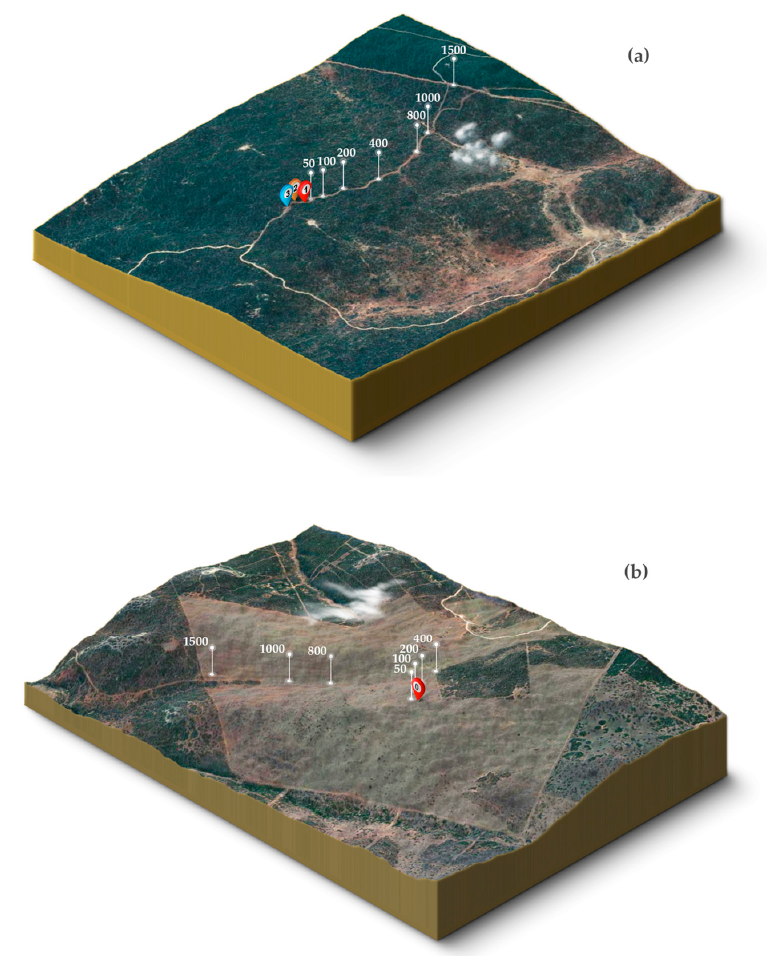
Figure 2. Topographical maps of both study sites, the densely vegetated ( a ) and the open ( b ) habitat. Vertical lines indicate the positions for each recording distance, ranging from 50 to 1500 m. The colored and numbered pins represent the fixed position of the subwoofer. In ( a ), pin #3 (in blue) corresponds to the position of the subwoofer for 1500 m, pin #2 (in orange) to the position of the subwoofer for 1000 m, and pin #1 for all other recording distances. Pin #0 (red) ( b ) represents the subwoofer’s position used to broadcast playback stimuli for all recording distances. Figures were generated using 3D Map Generator Terrain v1.4.2 (The Orange Box, Berlin, Germany) and Adobe Photoshop CC 2014 (Adobe Systems Incorporated, San Jose, CA, USA).